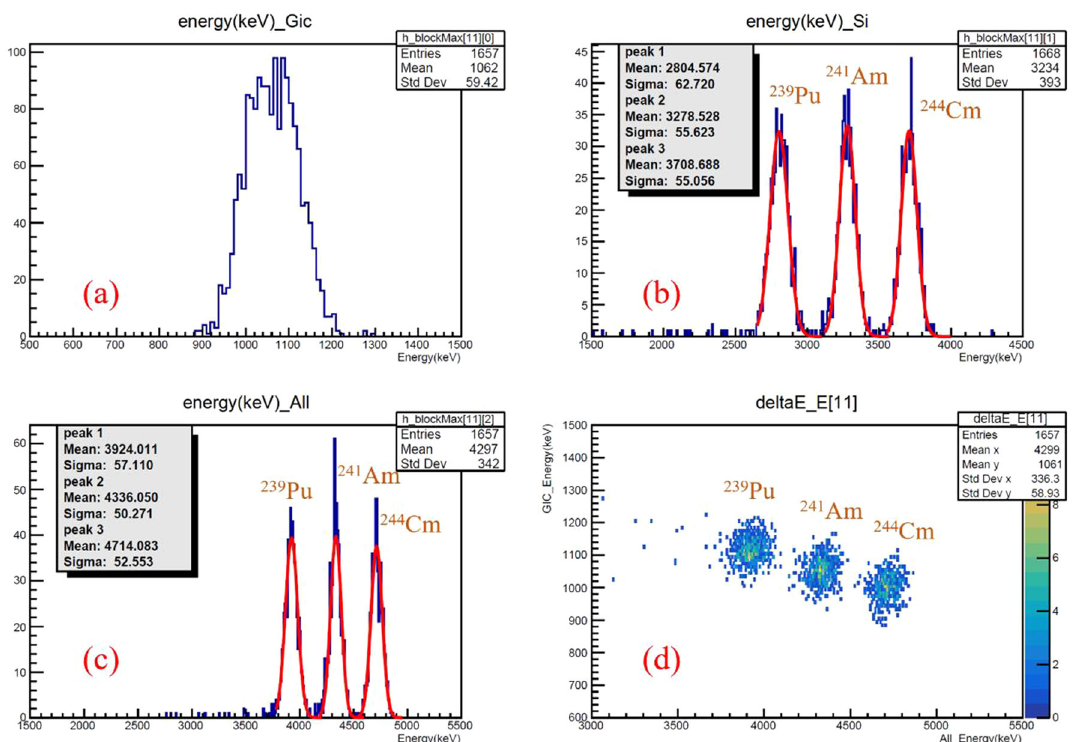
Fig. 10 Results of the measurement with a three-component alpha source for the telescope system with the SSA sealed windows: a the Δ E (energy deposit) spectrum of TFG-IC, b E deposited in the DSSSD, c